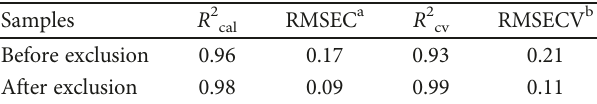
Table 2: Data set preprocessing and transformation on the model